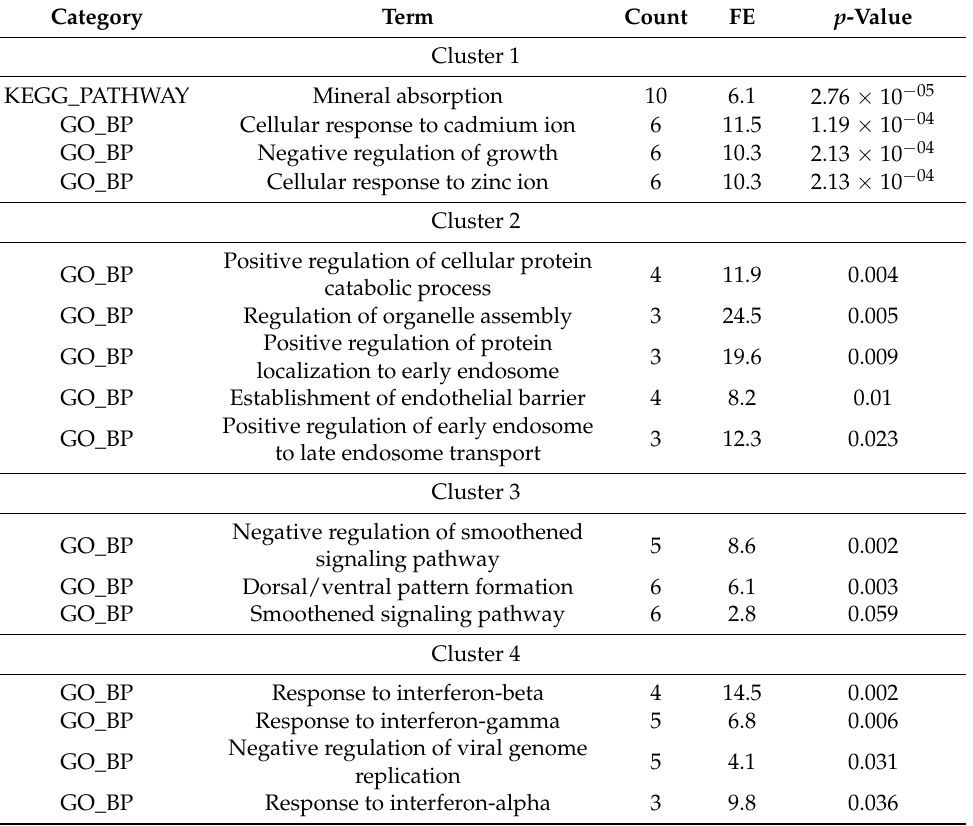
Table 4. Pathways significantly over represented in DEGs up-regulated in elderly vs. young